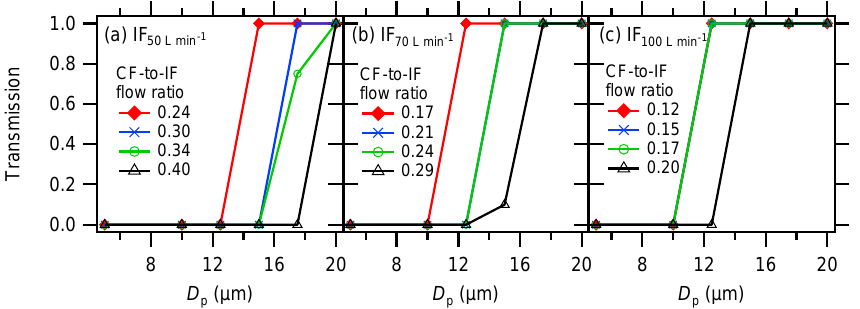
Figure 5. Comparison of the TE calculated from the CFD studies. The results of three different IFs (50, 70 and 100Lmin − 1 ) with various CF-to-IF flow ratios are shown in panel (a, b) and (c) , respectively. The CFD model simulates particles that are perfectly